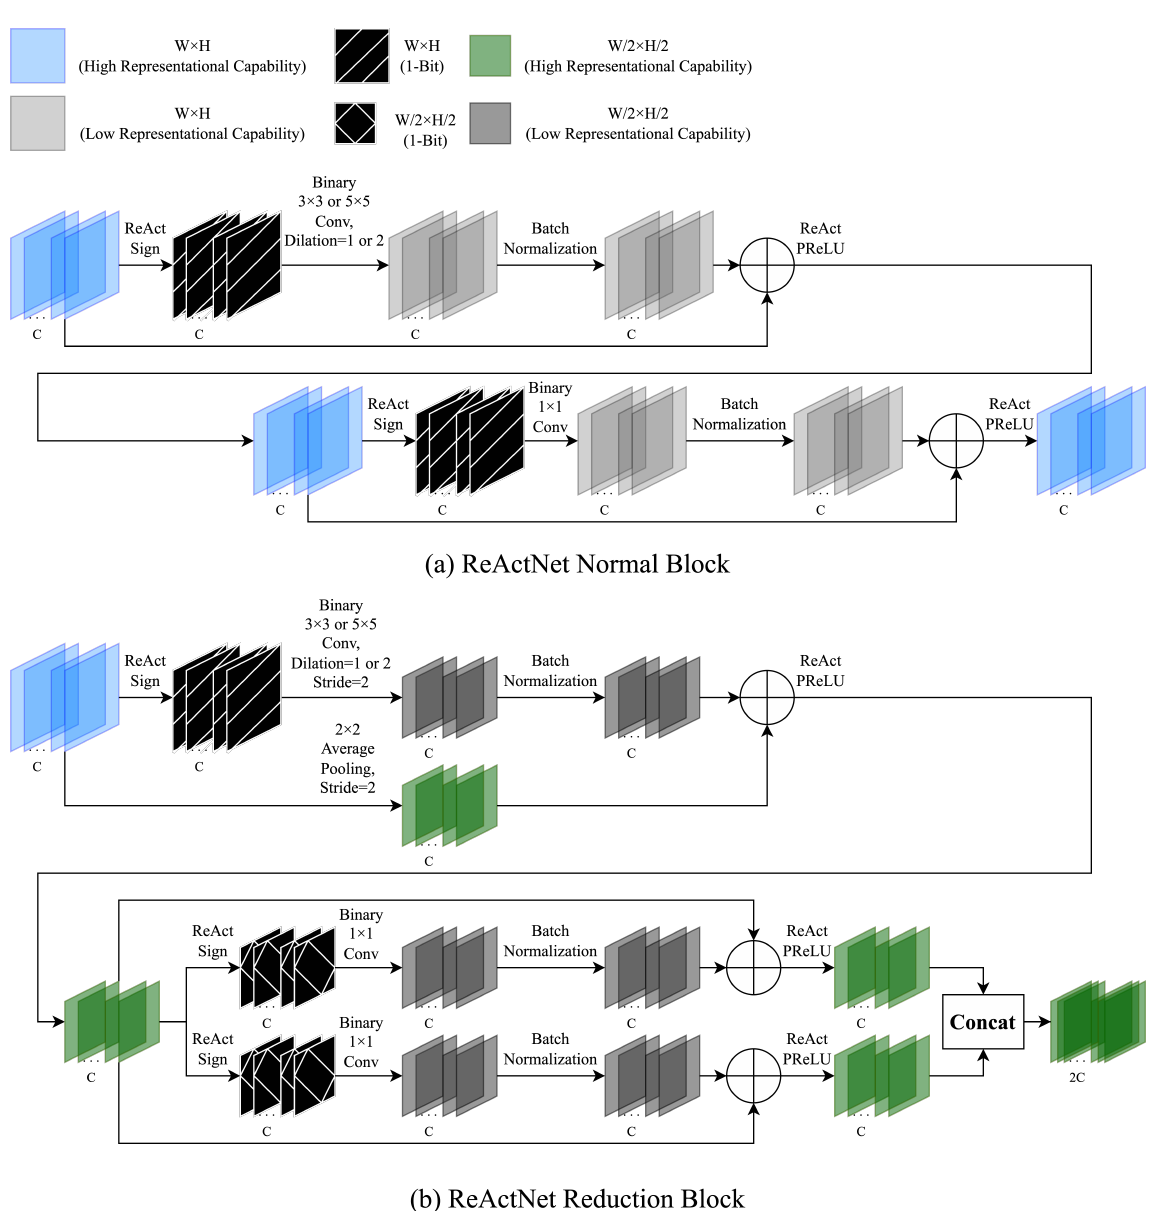
Figure 3. The architectures of the ReActNet Blocks in